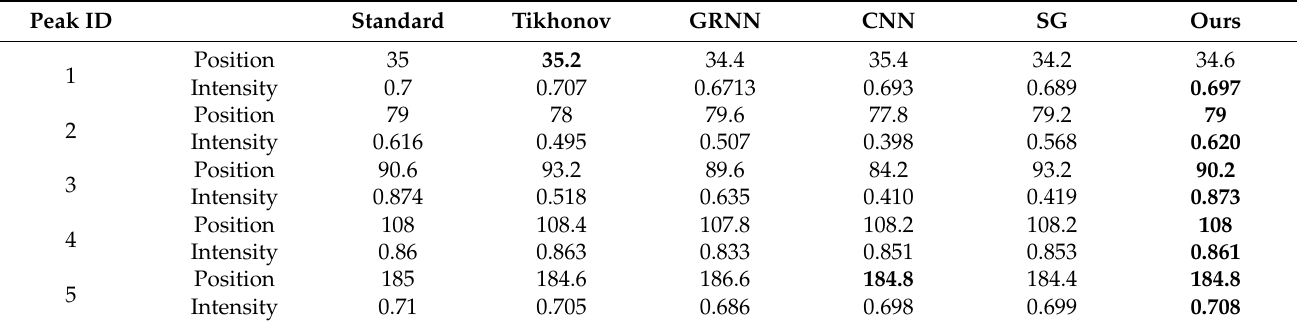
Figure 6. The denoising effect. ( a ) The noisy synthetic spectra. ( b – f ) Comparison of synthetic spectra with Tikhonov, GRNN, CNN, SG, and the proposed method, respectively. Table 3. The quantitative analysis of restored THz spectrum